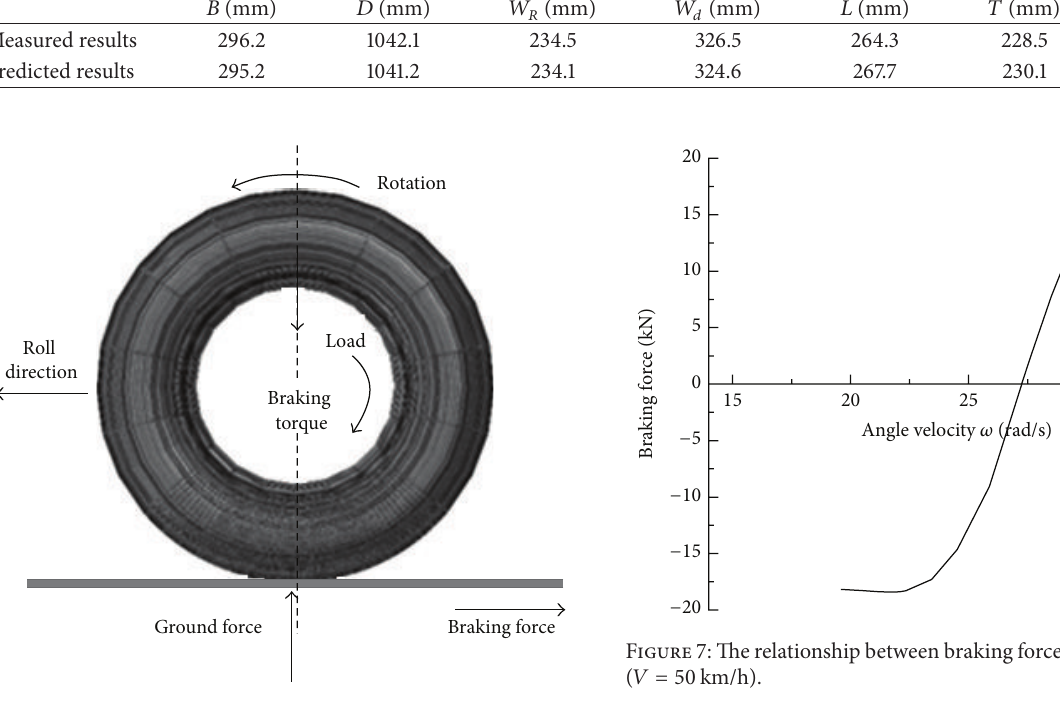
Figure 6: Illustration of tire braking simulation.